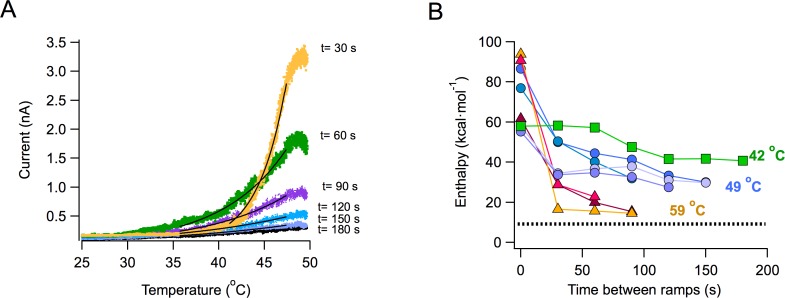
Inactivation by heat is accompanied by a loss of heat sensitivity.(A) Color traces are the activation curves from the same patch in response to six temperature ramps with a maximum temperature of 49.6°C applied at 30 s intervals. Black traces are fits to an exponential function, from which the ΔH was obtained. The values of ΔH for each time interval are: t = 0, 163.02 kcal⋅mol−1; t = 30 s, 70.954 kcal⋅mol−1; t = 60 s, 55.254 kcal⋅mol−1; t = 90 s, 38.092 kcal⋅mol−1; t = 120 s, 32.482 kcal⋅mol−1, t = 150 s, 28.91 kcal⋅mol−1. (B) Activation enthalpy is reduced with every consecutive activation ramp and the reduction is temperature dependent. Enthalpy estimated from the slope of the activation plotted as a function of the activation time interval. Each color represents a separate patch at the indicated maximum ramp temperature. The dotted line represents 10 kcal⋅mol−1, which is near the enthalpy of a diffusion process.